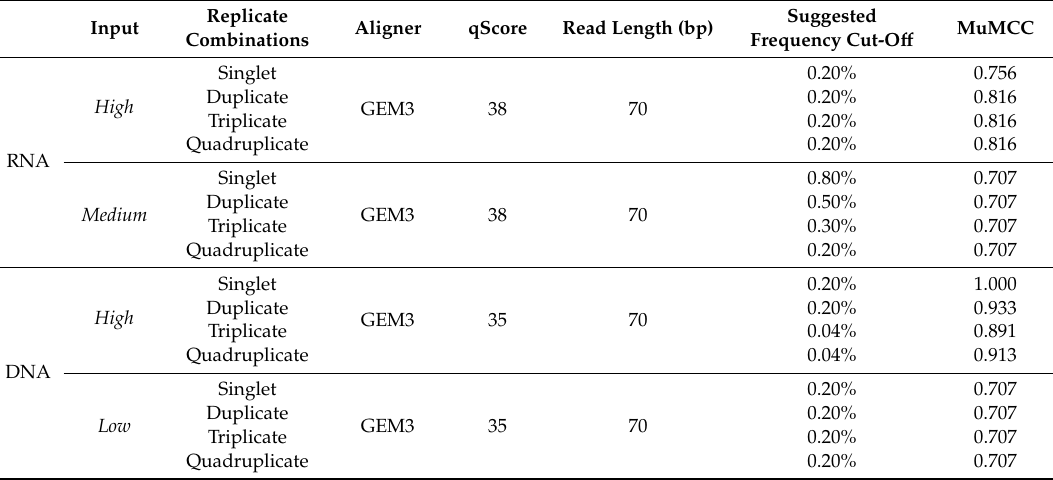
Table 2. The optimized computational parameters from all populations for low-frequency SNV characterisation. A list of chosen aligner and qScore, read length and frequency thresholds which produced the highest SNV detection accuracy for all population types and replicate numbers is given. The RNA Low input was removed due to its inability to accurately call low-frequency